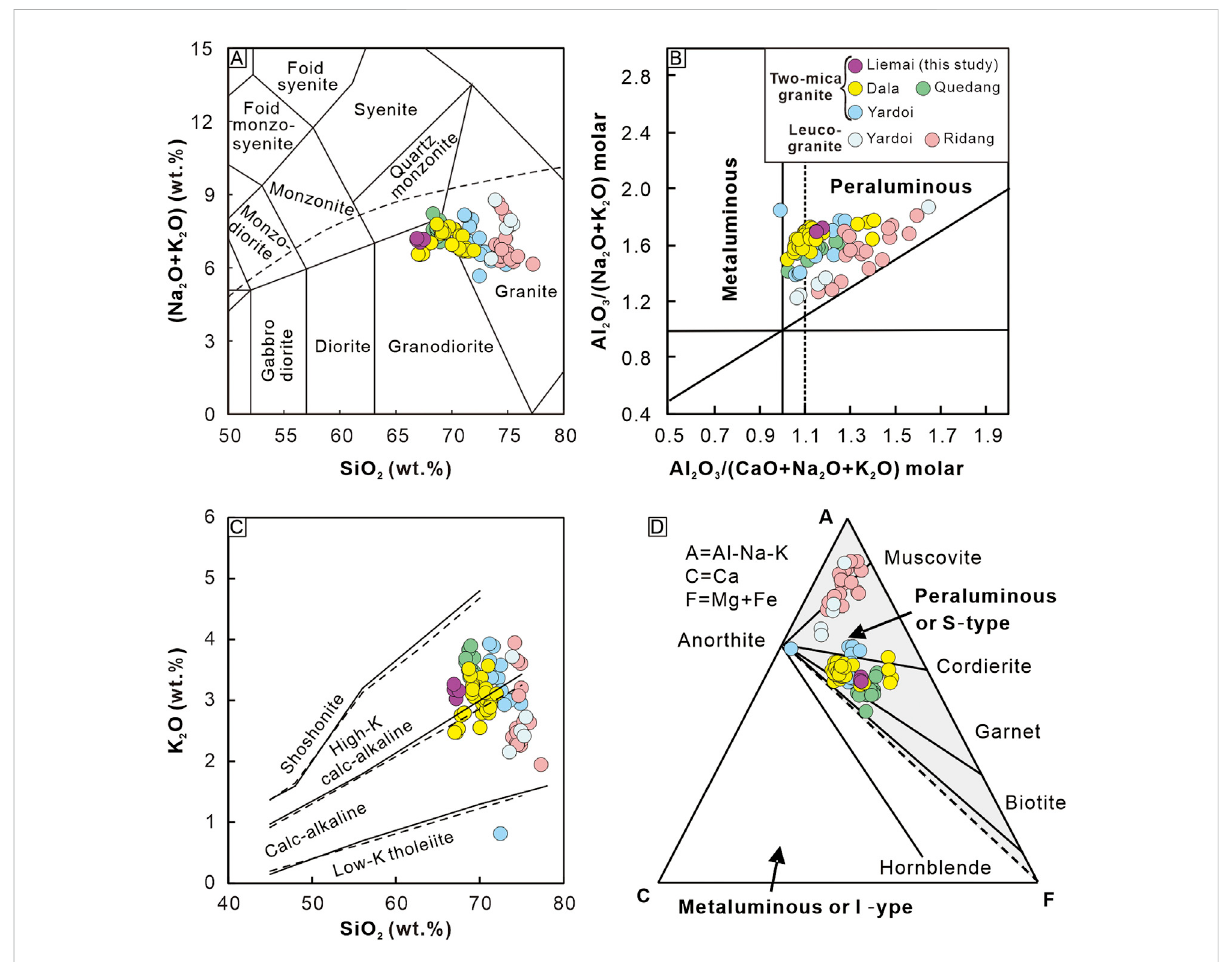
FIGURE 5 (A) SiO 2 vs. K 2 O + Na 2 O (Middlemost, 1994), (B) A/CNK vs. A/NK (Maniar and Piccoli, 1989), (C) SiO 2 vs. K 2 O (Rickwood, 1989), and (D) A-C-F (Chappell and White, 1992) diagrams for the Liemai two-mica granite. Data source: Quedang two-mica granites are from Zeng et al. (2011) and Hou etal.(2012);Dalatwo-micagranitesarefromZengetal.(2011,2015),Houetal.(2012)andDaietal.(2020a);Yardoitwo-micagranitesarefromZeng etal.(2011,2015);YardoileucogranitesarefromZengetal.(2015);Ridangleucogranites(subvolcanicrocks)arefromHuetal.(2011b)andZeng et al.